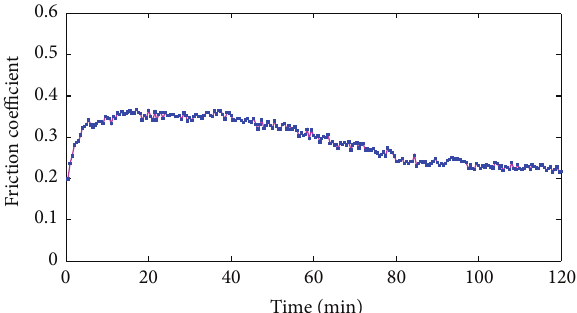
Figure 7: Friction coefficient curve of the gradient layer infiltrated with Pb28Sn19Ag6Cu sliding against Al 2 O 3 .